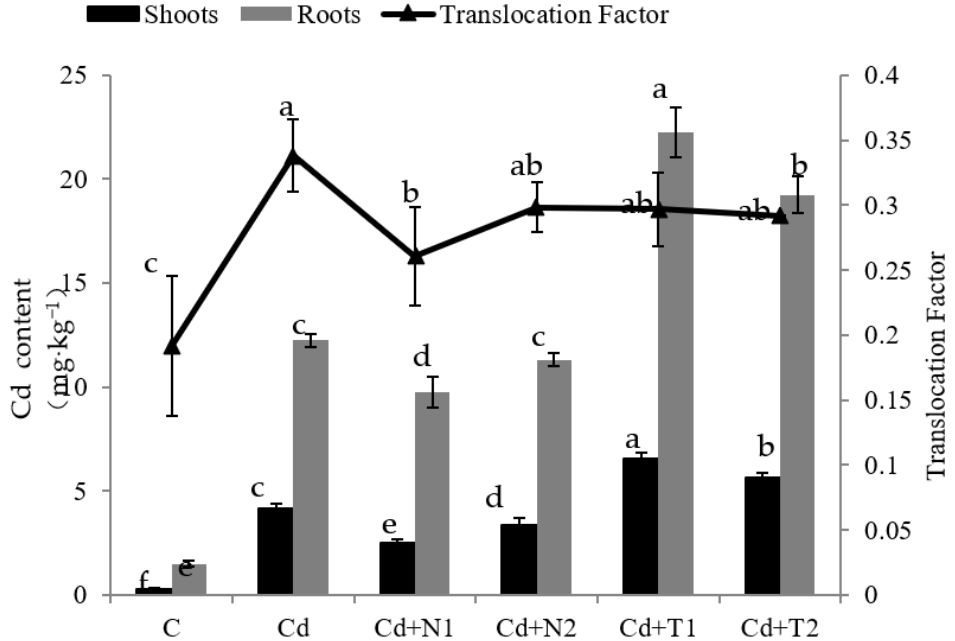
Figure 3. Cd uptake and translocation of tomato plants under Cd stress. The lowercase letters in- dicate the significant differences at 5% level. C: 0 μ M Cd; Cd: 50 μ M Cd; Cd + N1: 50 μ M Cd +